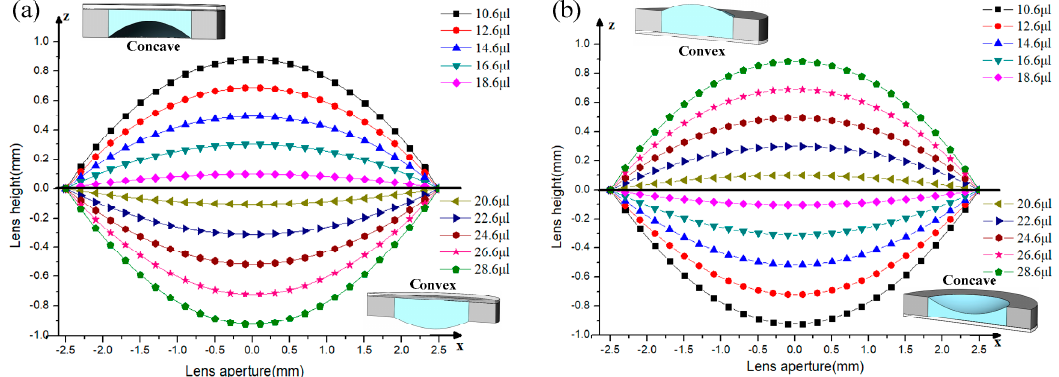
Figure 5. The LFS profiles of the LFL. ( a ) Inverted state. ( b ) Positive state.